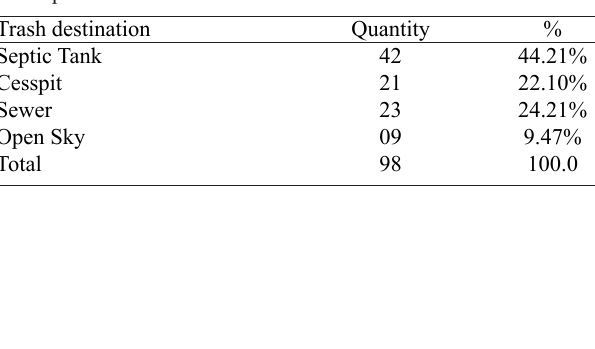
Table 1. Distribution of trash destination of children with congenital cardiopathies in São